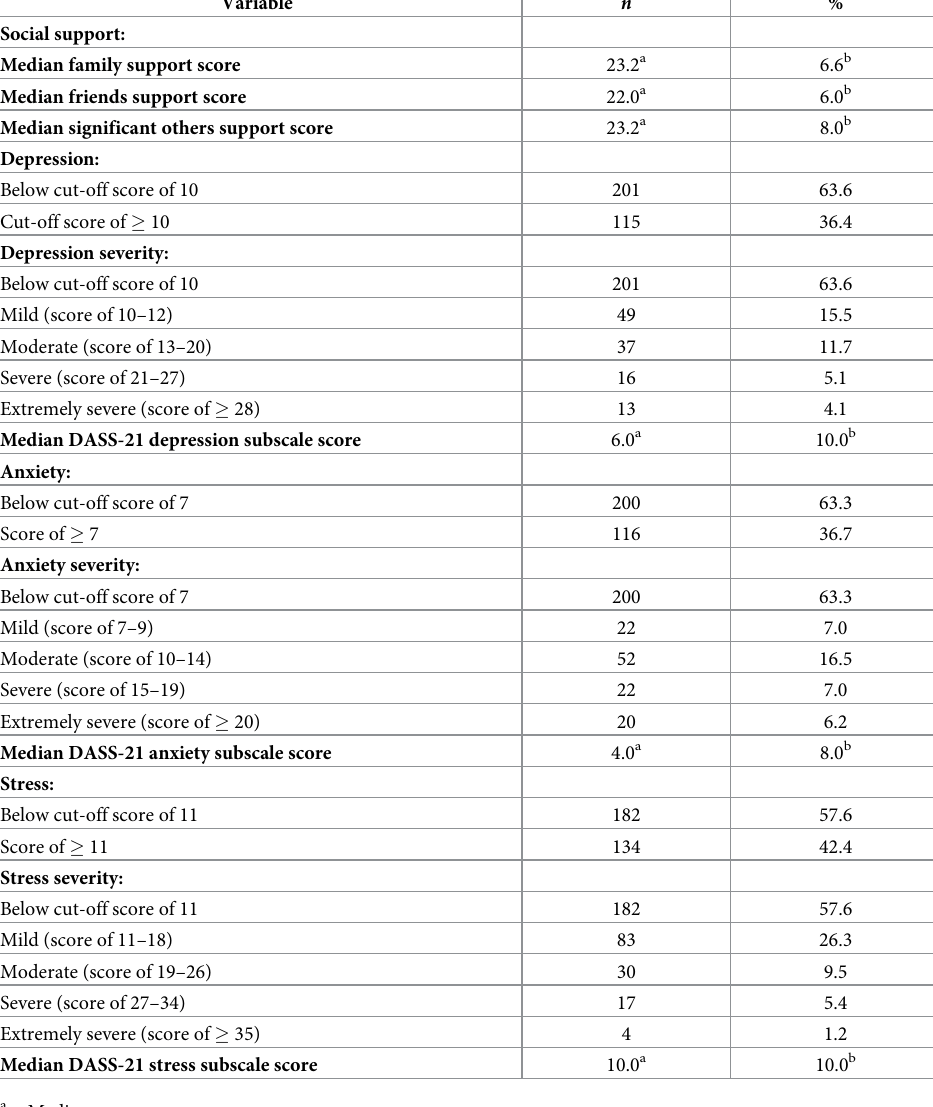
Table 2. Social support and psychological characteristics of the